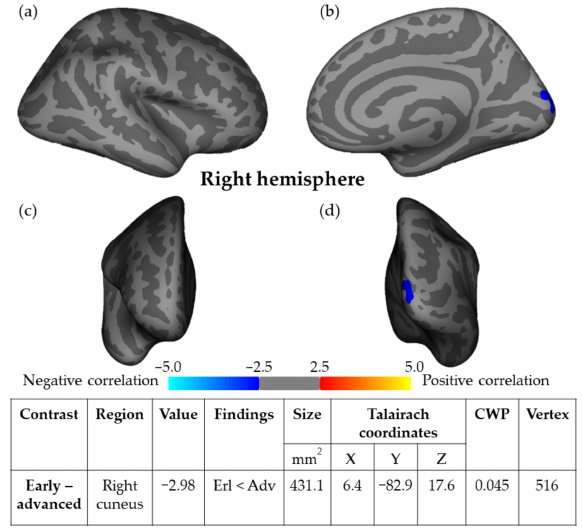
Figure 3. Cortical thickness maps showing significant thinning in the right hemisphere cuneus in early-stage NTG as compared to advanced NTG stage in ( a ) lateral, ( b ) medial, ( c ) anterior, and ( d ) posterior views. Results were obtained using Monte Carlo simulation, with a threshold of p < 0.01, to provide clusterwise correction for multiple comparisons. Table 4. Parametric (Pearson’s) and nonparametric (Spearman’s) correlation analyses between LGN volume and the clinical parameters (MD and RNFL) in studied groups. Statistically significant results are marked